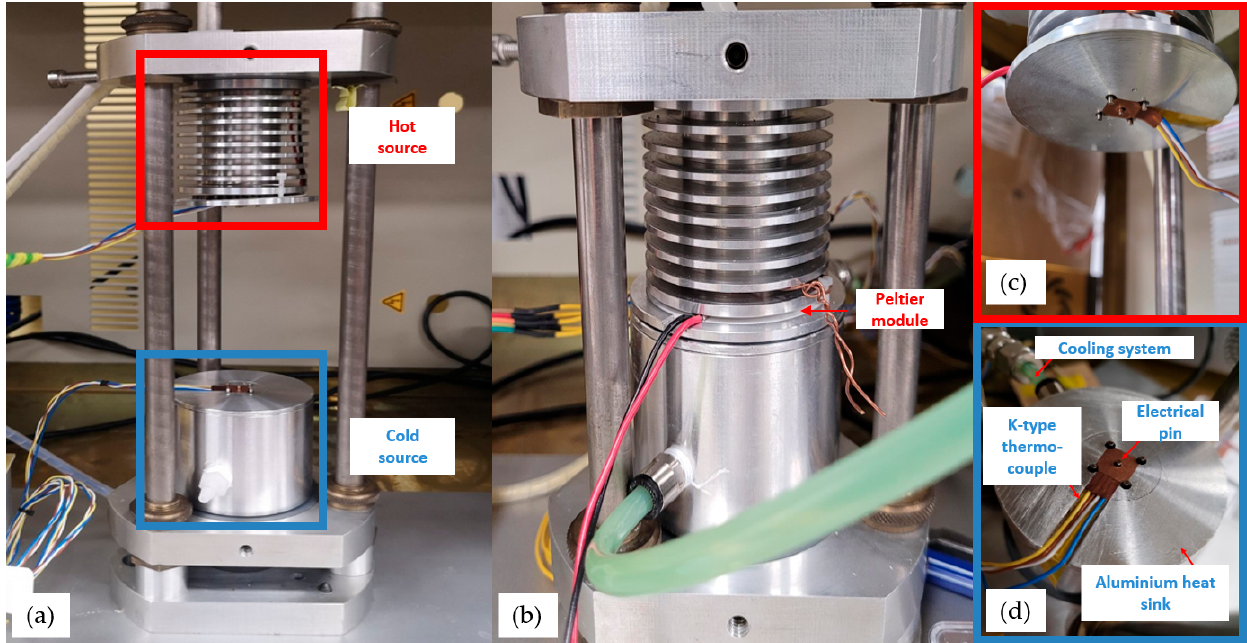
Figure 8. ( a ) Homemade ZT meter device for in-depth S measurement: view before measurement; ( b ) closed system with a mobile upper part: view during measurement; ( c ) zoom on hot block; ( d ) zoom on cold block with integrated sensors description.